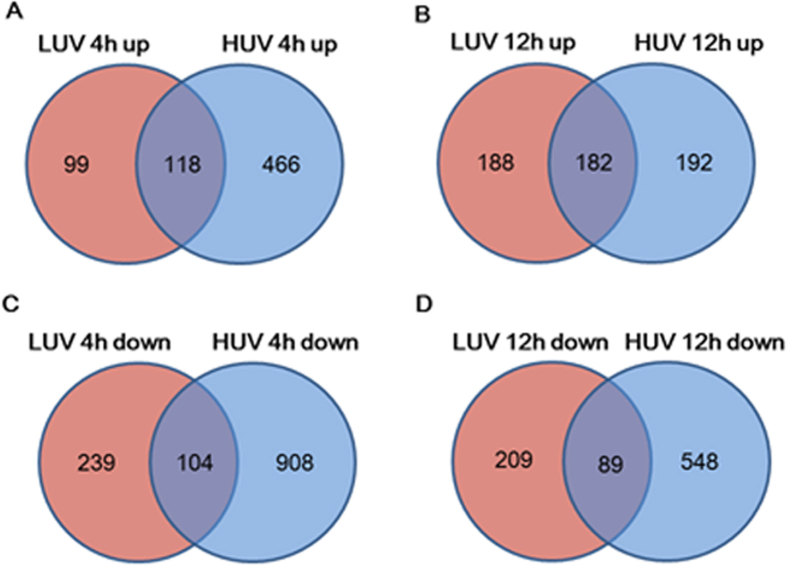
Venn diagram indicating the number of upregulated or downregulated genes following UV-C irradiation.The number of significantly altered genes (≥2-fold difference) at 4 or 12 h after UV exposure is indicated. LUV: lower dose of UV-C; 0.5 J/m2. HUV: higher dose of UV-C; 5 J/m2. The number of upregulated genes at 4 h (A) and at 12 h (B) is shown. The number of downregulated genes at (C) and at 12 h (D) is shown.